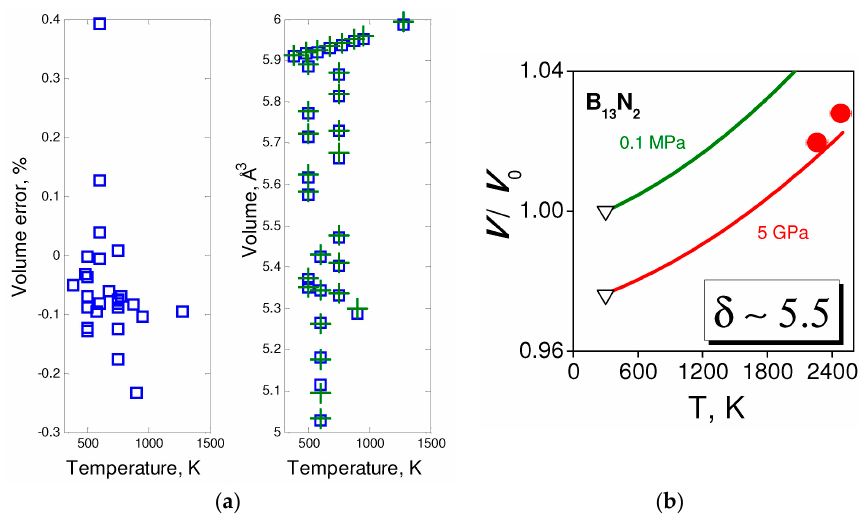
Figure 6. p-V-T equations of state: ( a ) cBN, experimental data from [60], adjusted to p-V-T EOS; and ( b ) B 13 N 2 , experimental data from [62], adjusted theoretical values for EOS parameters.